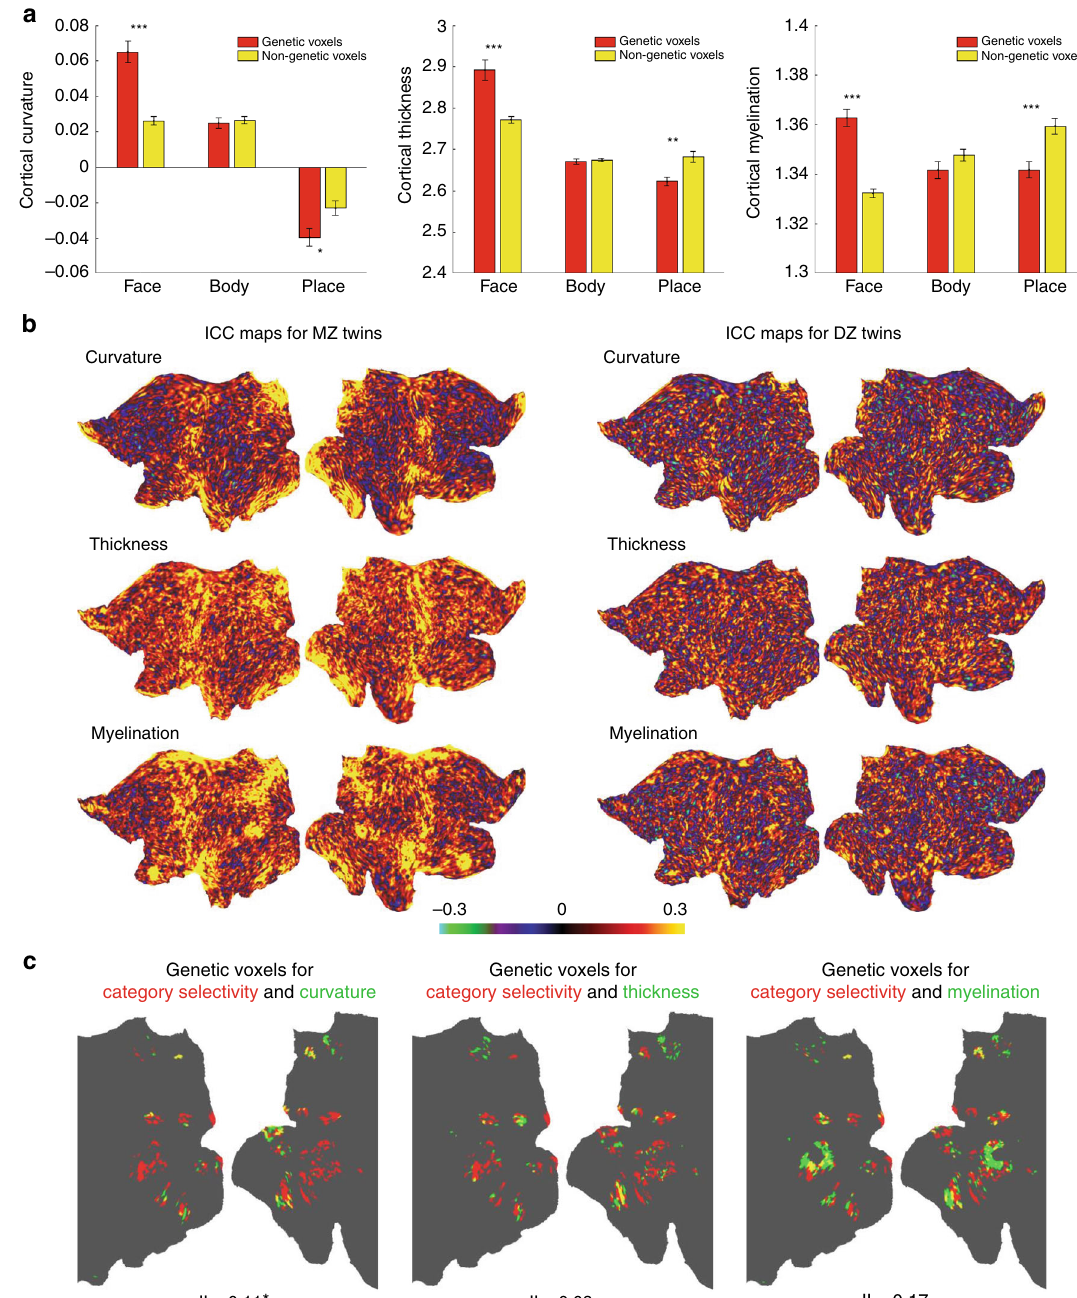
Fig. 3 Relationship between genetic effect in category-selective areas and structural/morphological properties of cortical gray matter. a In face, body, and place areas, mean cortical curvature, mean cortical thickness, and mean cortical myelination were computed across genetic and nongenetic voxels. Place-selective voxels in V1/V2/V3 were excluded in this analysis. Regions with positive curvature corresponded to cortical gyri, and regions with negative curvature corresponded to cortical sulci. * p < 0.05, ** p < 0.005, *** p < 0.0005; Bonferroni-corrected pooled t test for three comparisons between genetic and nongenetic voxels in each plot. b ICC maps for curvature, thickness, and myelination in MZ and DZ twins, displayed on a 2D fl at patch of left and right hemispheres. c Using the same procedure for estimating the heritability of category selectivity (see Methods), the heritability of curvature, thickness, and myelination was estimated in each category-selective voxel. The maps show voxels with genetic in fl uence on category selectivity (red), cortical structure (green), or both (yellow). The degree of overlap between the binary genetic in fl uence maps was quanti fi ed using the Jaccard Index (JI). JI was low in all cases. In the case of curvature, it was slightly and signi fi cantly above the expected JI under independence ( p < 0.05; bootstrap test). In the case of thickness and myelination, the difference was not signi fi cant ( p > 0.05; bootstrap